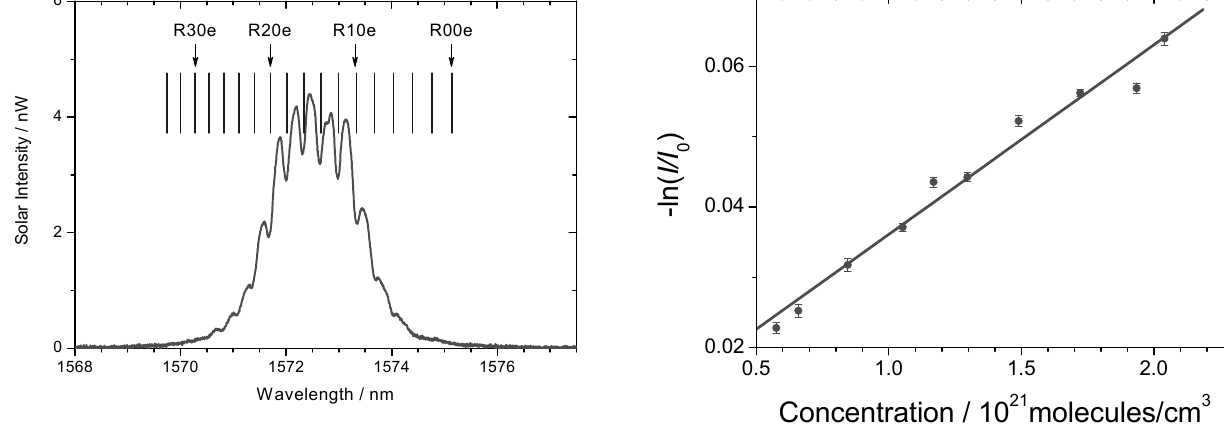
Fig. 10 Fig. 10. Spectral profile of the sunlight through a narrow bandpass filter. Assignments for the R-branch in the CO 2 (30012 ← 00001) transition are shown.